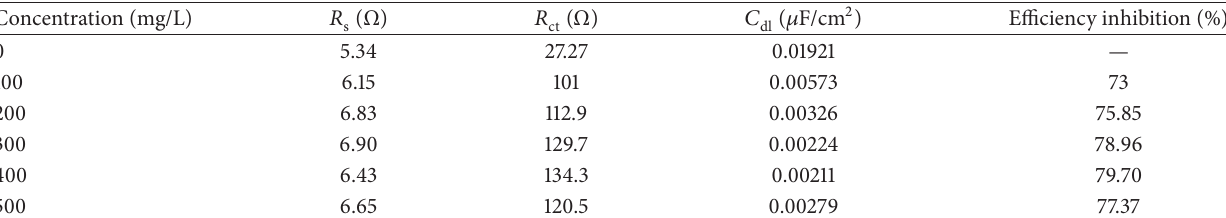
Table 2: The parameters obtained from EIS measurements.